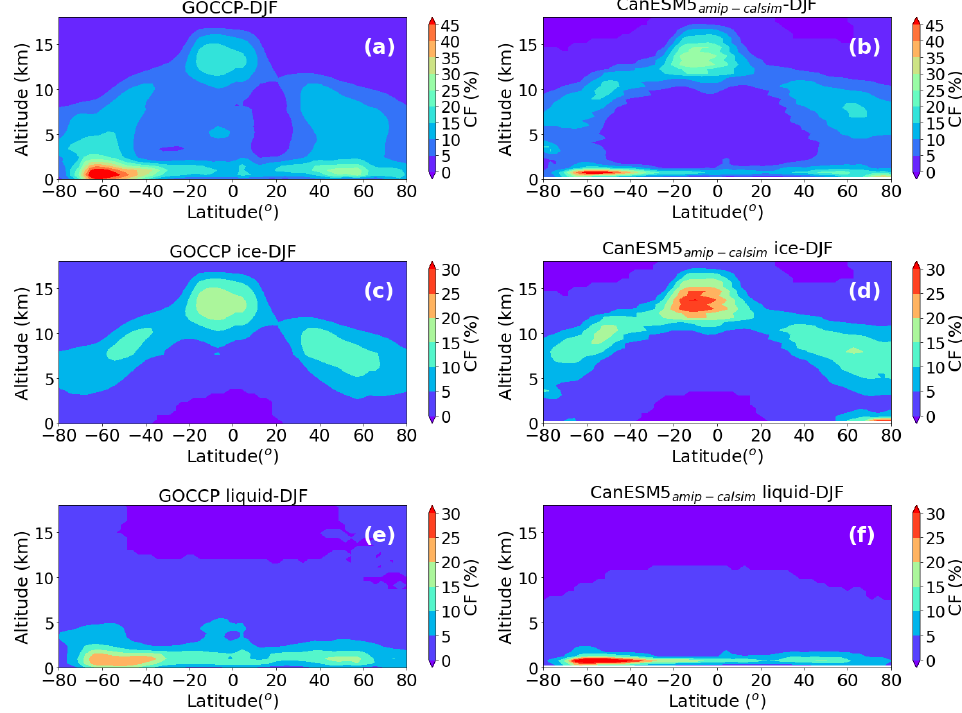
Figure 12. Similar to Figure 11, but the DJF season.